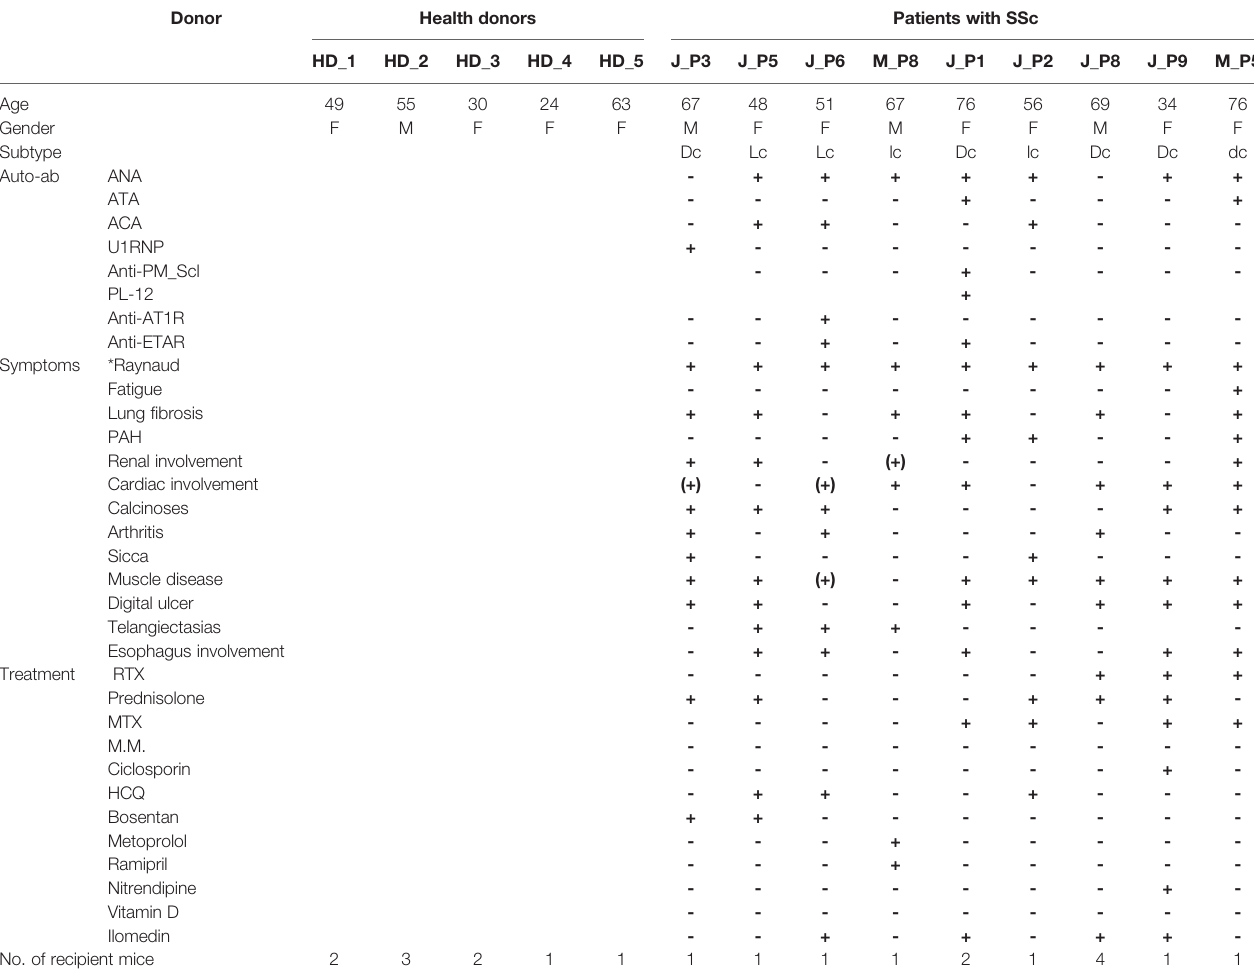
TABLE 1 | Demographic and clinical features of healthy donors and SSc patients. Donor Health donors Patients with